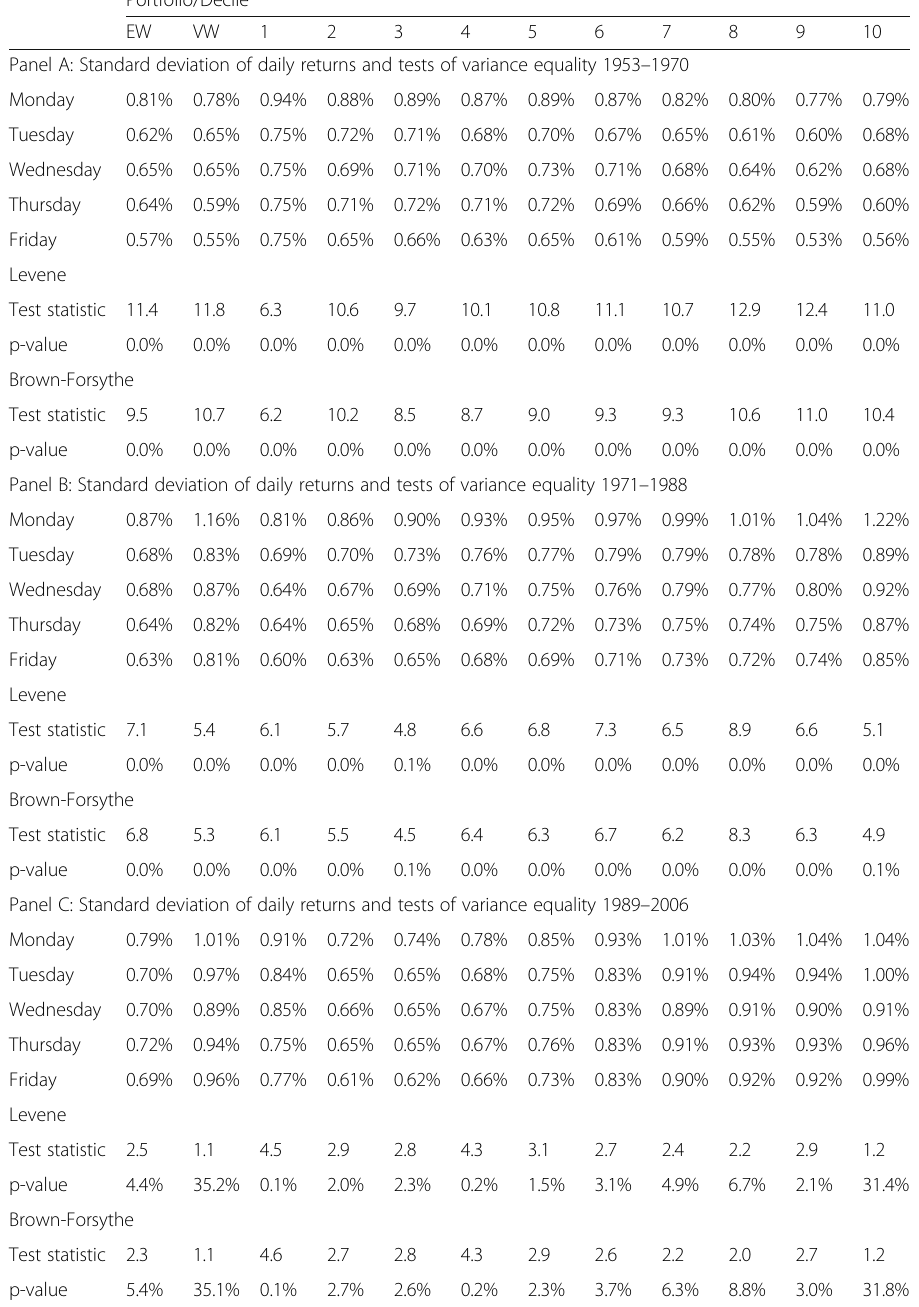
Table 3 Are variances equal across days of the week? Subperiod analysis